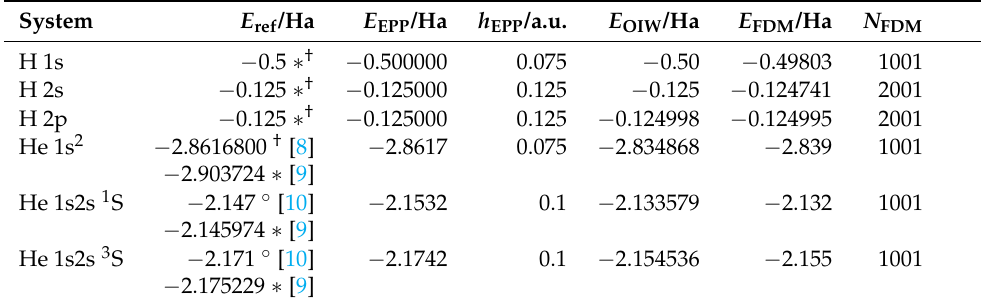
Table 1. Hartree–Fock total energies of H and He occupation configurations. E ref are chosen reference values. E EPP is the energy given by the EPP–Galerkin-method, h EPP is the grid spacing in the EPP– Galerkin method, E OIW is the energy given by the OIW–Galerkin method, E FDM is the energy given by the Finite Difference Method, and N FDM is the number of grid points in the Finite Difference Method. For EPP, the most accurate results are given. For OIW computations, the number of basis functions is 201 and the finest grid spacing is 0.00625